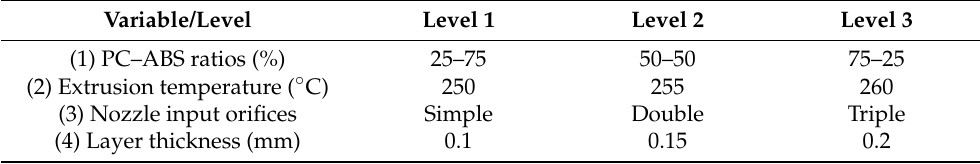
Table 1. Process variable of the Taguchi L9 matrix.